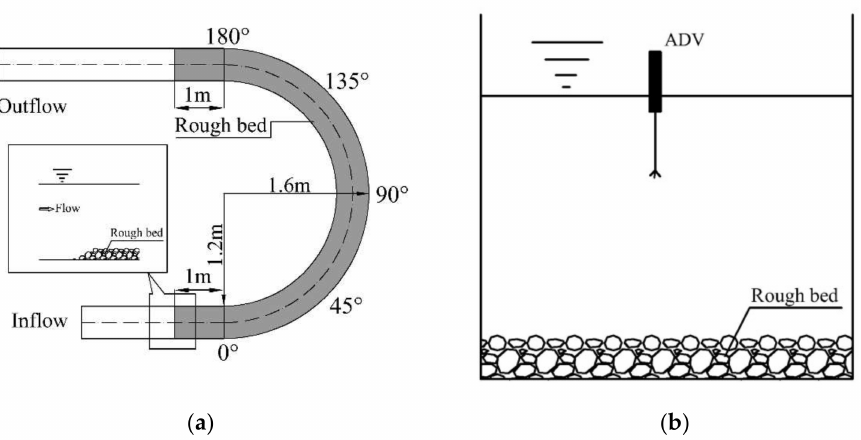
Figure 1. Scheme of experiment setup: ( a ) The shadow shows rough bed regions and the inset figure represents rough bed configurations; ( b ) ADV measurement